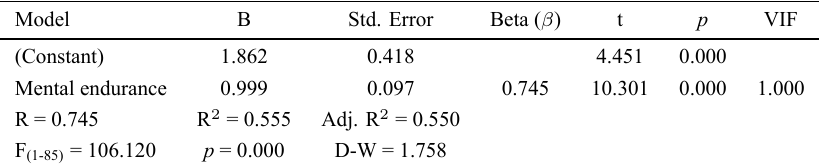
Table 3. Regression analysis